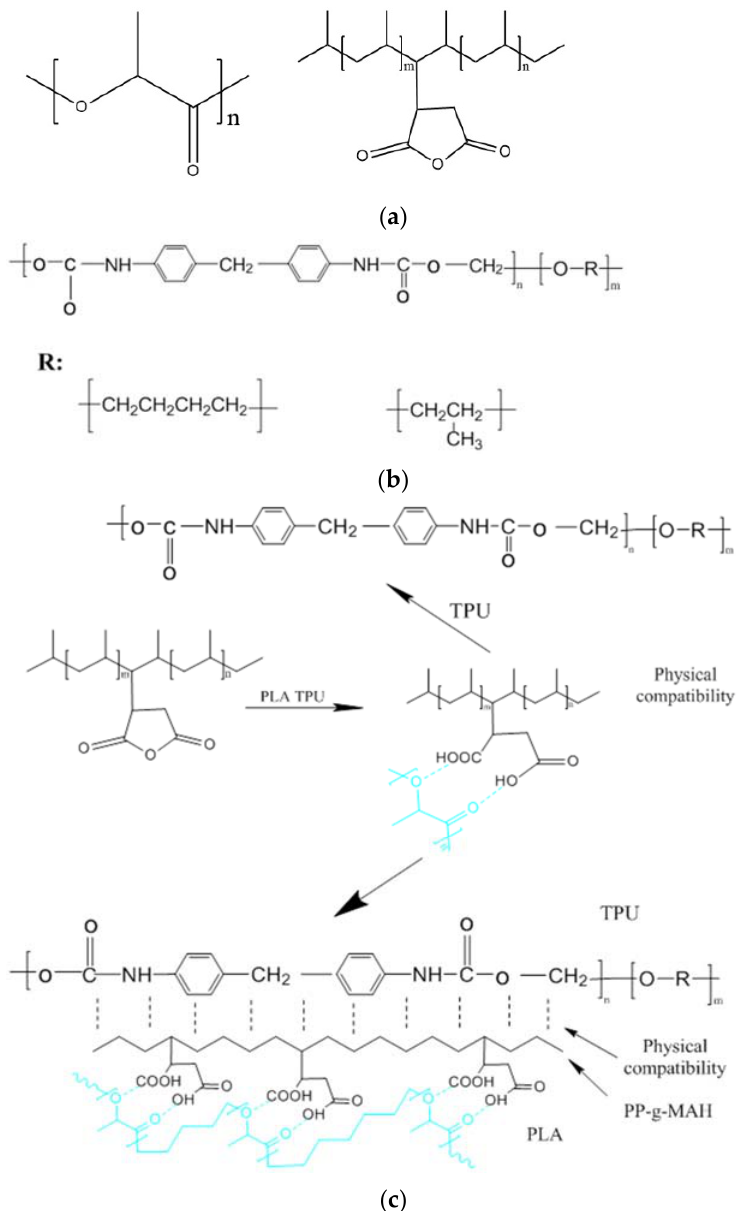
Figure 5. Structural representation. ( a ) Molecular structure of PLA and PP- g -MAH. ( b ) Structure diagram of TPU. ( c ) Compatibility mechanism of PP- g -MAH compatibilizer.